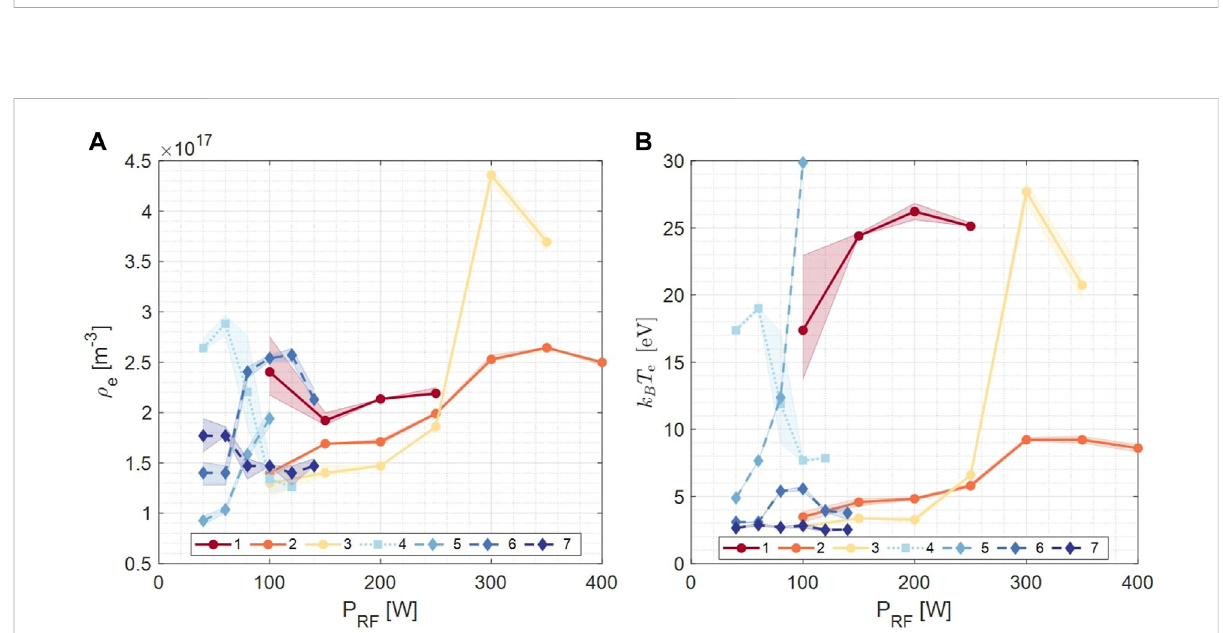
FIGURE 8 (A) Averaged density ρ e [m − 3 ] vs. P RF [W] over all spectra for each RF power, including uncertainty range from the graphical solution of the non- linear system, as shown in Figure 6 (shaded region). (B) Averaged electron energy k B T e [eV] vs. P RF over all spectra for each RF power, including uncertainty range from the graphical solution of the non-linear system, as shown in Figure 6 (shaded region). Different experimental run are labeled according to Table 2 and shown in the